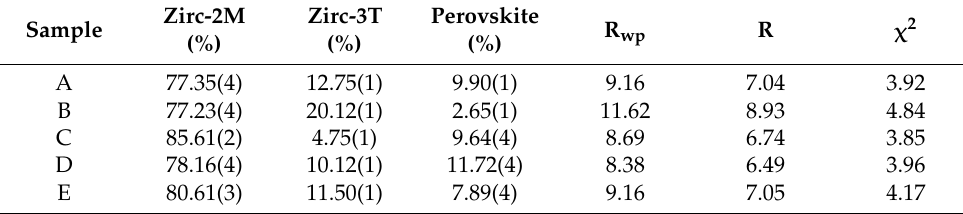
Table 2. The weight ratio of phases and R wp , R and χ 2 values of Samples